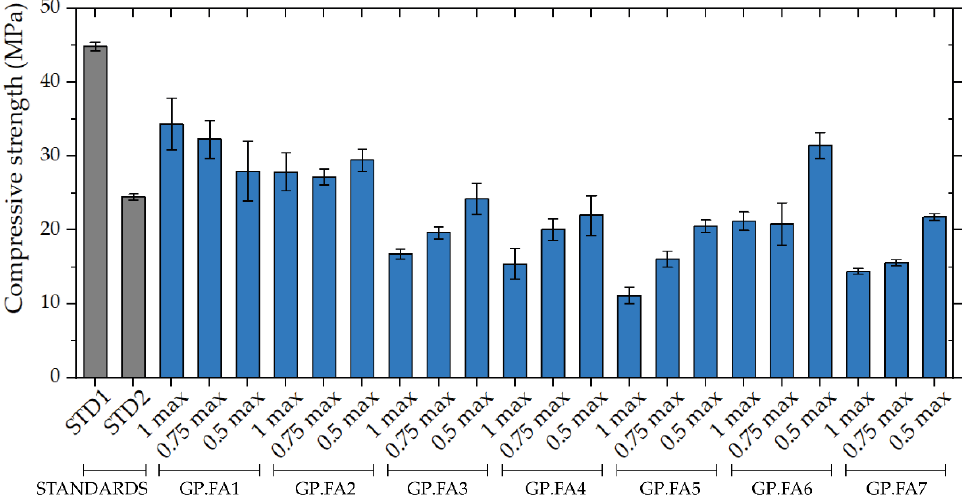
Figure 4. Compressive strengths of geopolymers with FA1 – 7.